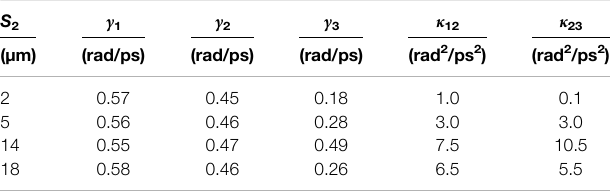
TABLE 2 | Parameters used in the coupled Lorentz model for the calculation of M123.